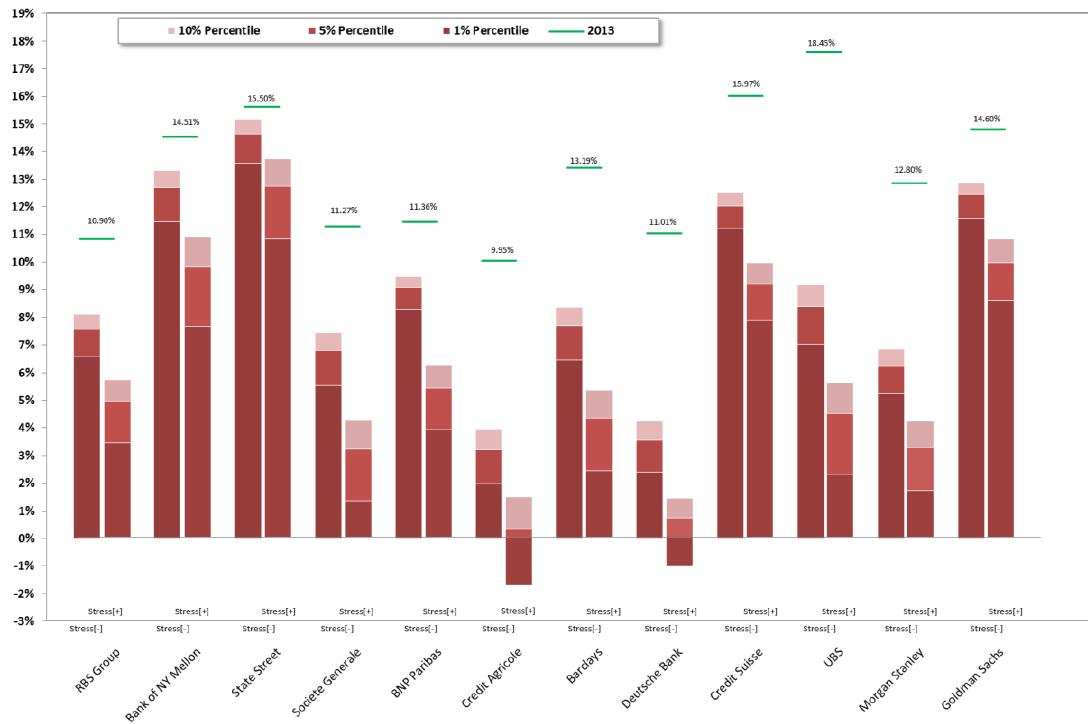
Figure 3. Stressed CET1 ratio 2015 vs. CET1 ratio 2013. IB & IBU.